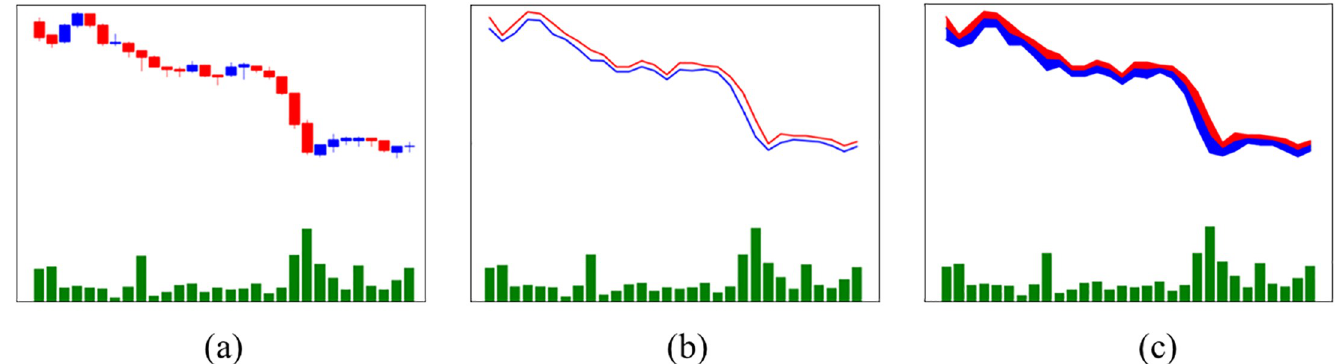
Fig 4. Three fusion chart images using early fusion. The time interval is between t − 30 and t. (a) Candlebar chart, (b) Linebar chart, and (c) F-linebar chart.